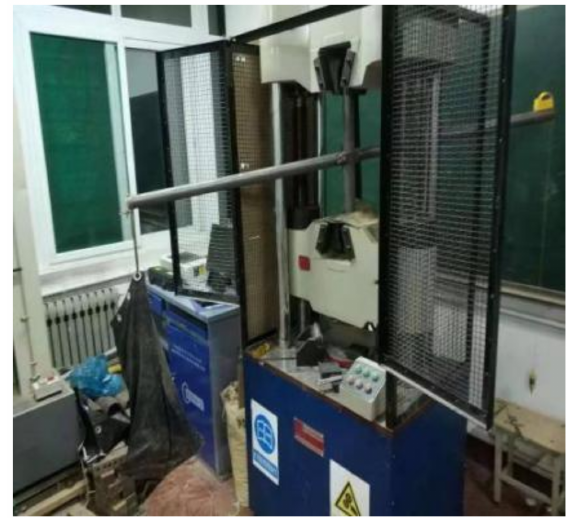
Figure 2. Deformation of bar under